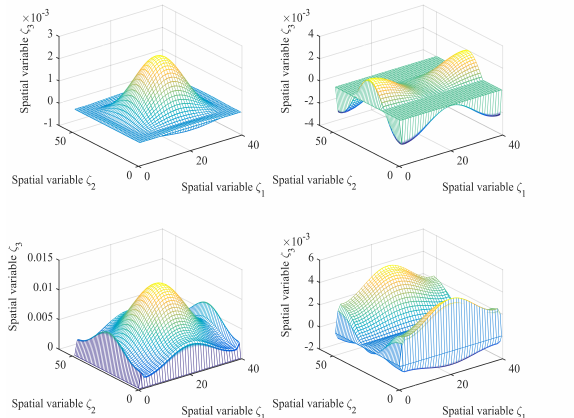
Figure 3. Sensor measurement output.